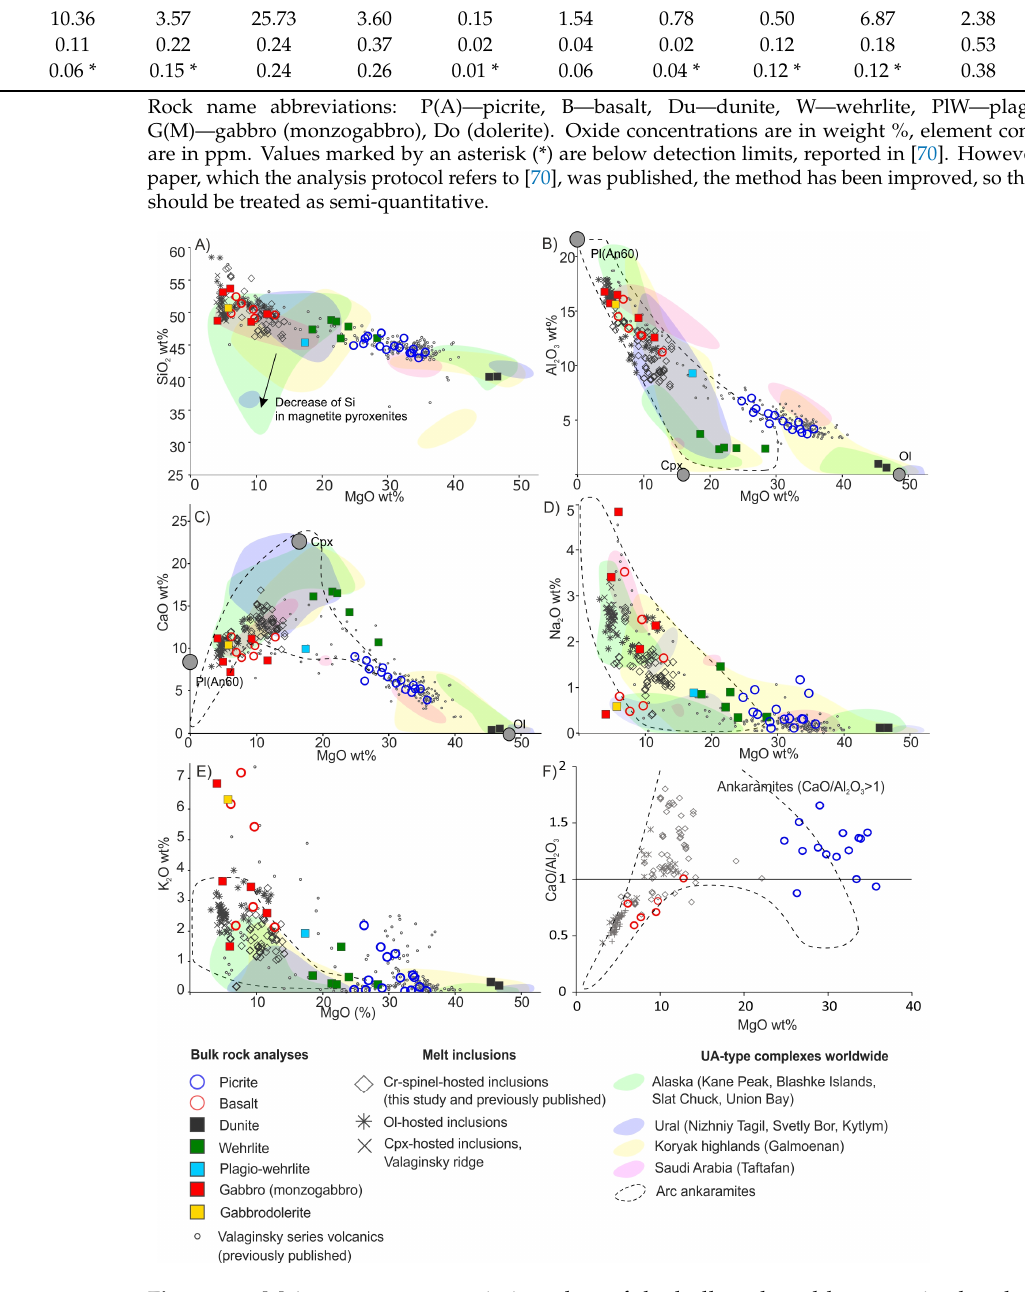
Figure 10. Major component variation plots of the bulk-rock and homogenized melt inclusions’ compositions. ( A ) MgO-SiO 2 plot; ( B ) MgO-Al 2 O 3 plot with points of average olivine and clinopy- roxene compositions and plagioclase (An 60 ) from the studied rocks; ( C ) MgO-CaO plot with the points of mineral compositions the same as on ( B ); ( D ) MgO-Na 2 O plot; ( E ) MgO-K 2 O plot; ( F ) MgO- CaO/Al 2 O 3 plot: only for the volcanics. Data for melt inclusions are from this study and [54,61]. Data sources for comparison of the UA-complexes worldwide are as in Figure 7. Fields for arc ankaramites are after